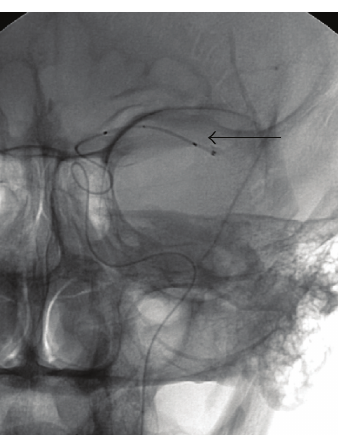
Figure 3: Vascular retrieval snare in the distal part of microcatheter. The snare (arrow) has been deployed out of the microcatheter just enough to open fully, and retrieved back in the microcatheter.